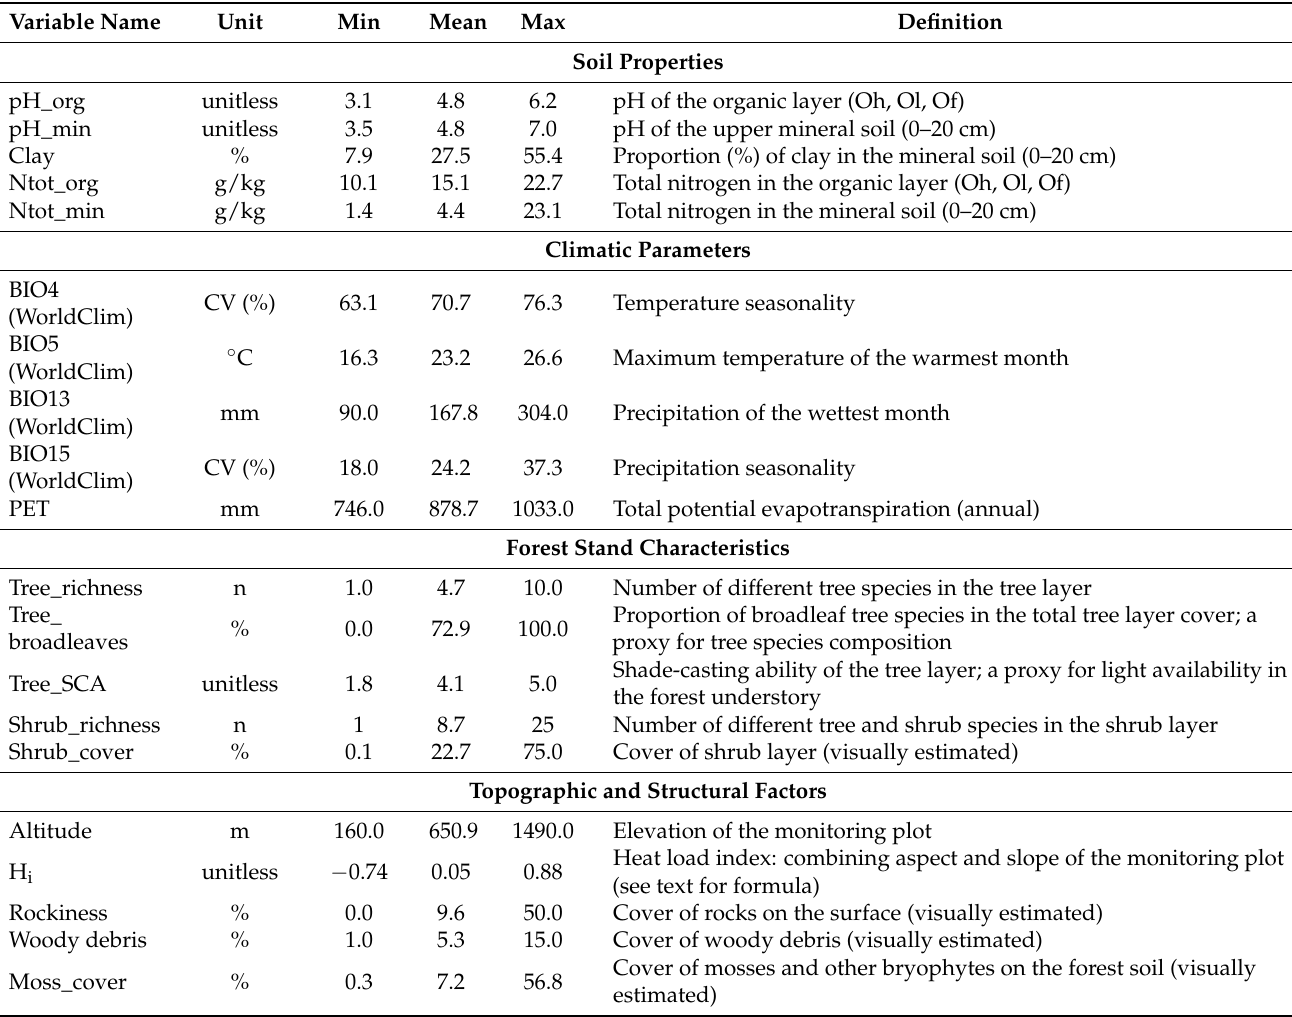
Table 1. Four groups of explanatory variables (predictors) related to soil properties, climatic parameters, forest stand characteristics and topographic and structural factors. Each group contains five different plot-level variables, yielding 20 predictors in